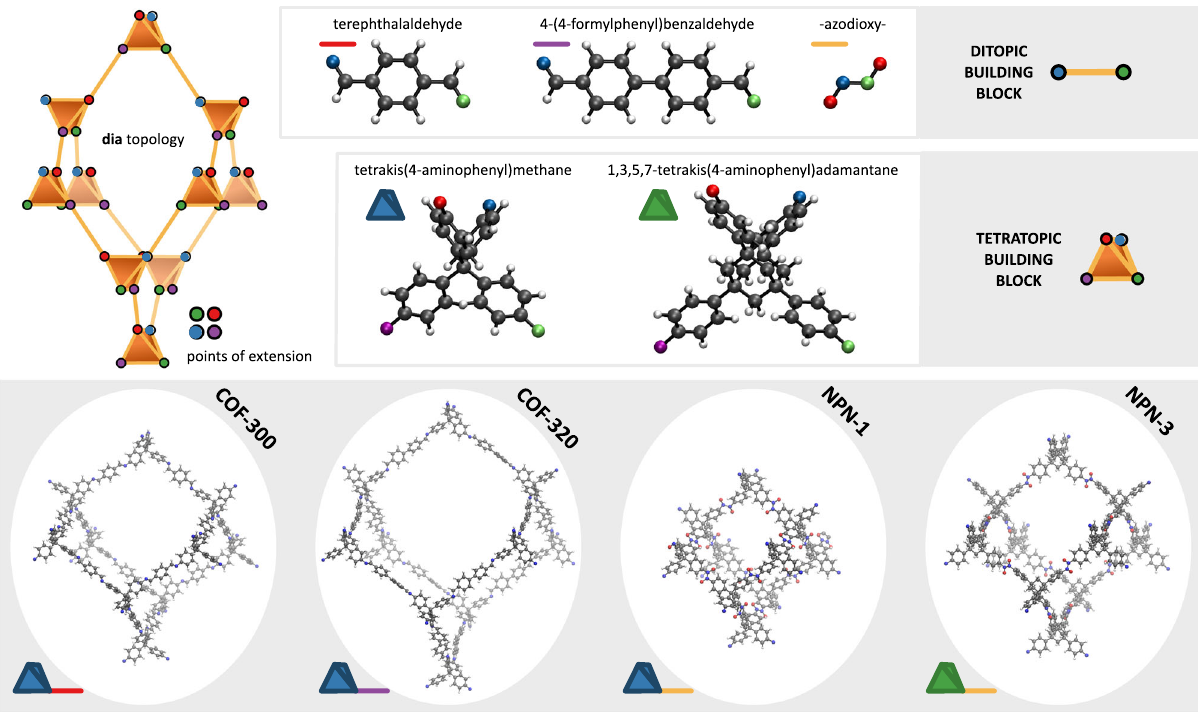
Fig. 1 Illustration of the four considered materials, and their ditopic and tetratopic building blocks. As the NPN COFs form an azodioxy linkage through selfcondensation during synthesis, the ditopic building block is labelled as such instead of its precursor. Additionally, the four unique points of extension for each tetratopic building block, coinciding with the nitrogen atoms, have been indicated by the red, green, blue and purple